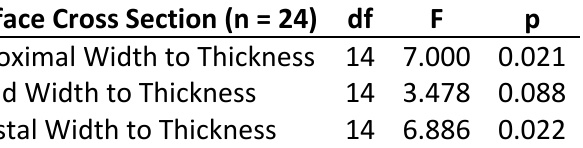
Table 15. ANOVA results for comparison of Index of Invasiveness and cross section